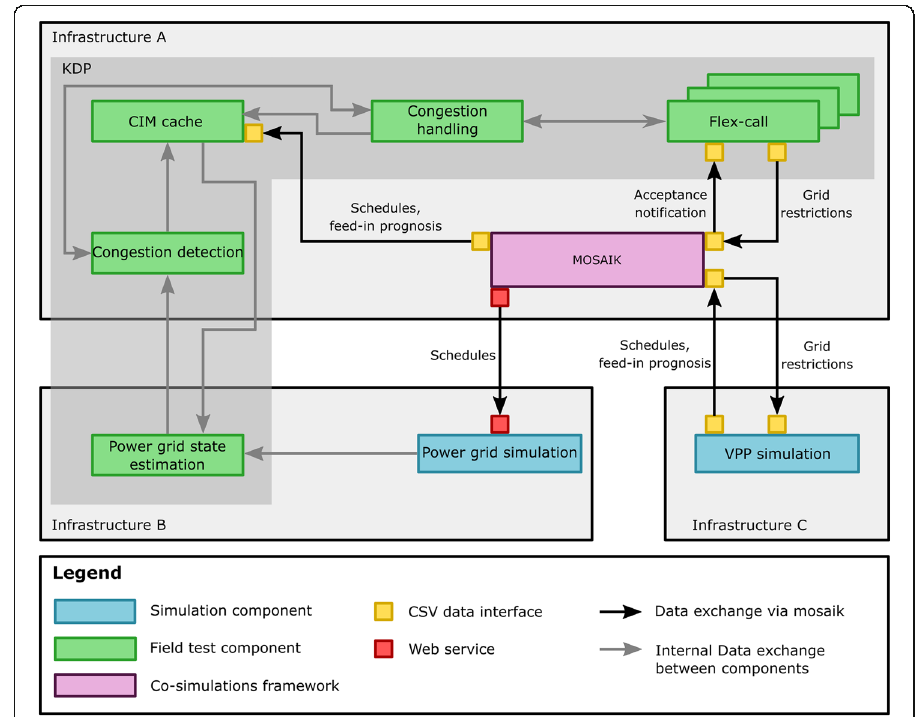
Fig. 1 Components of the co-simulation setup and the data flow between